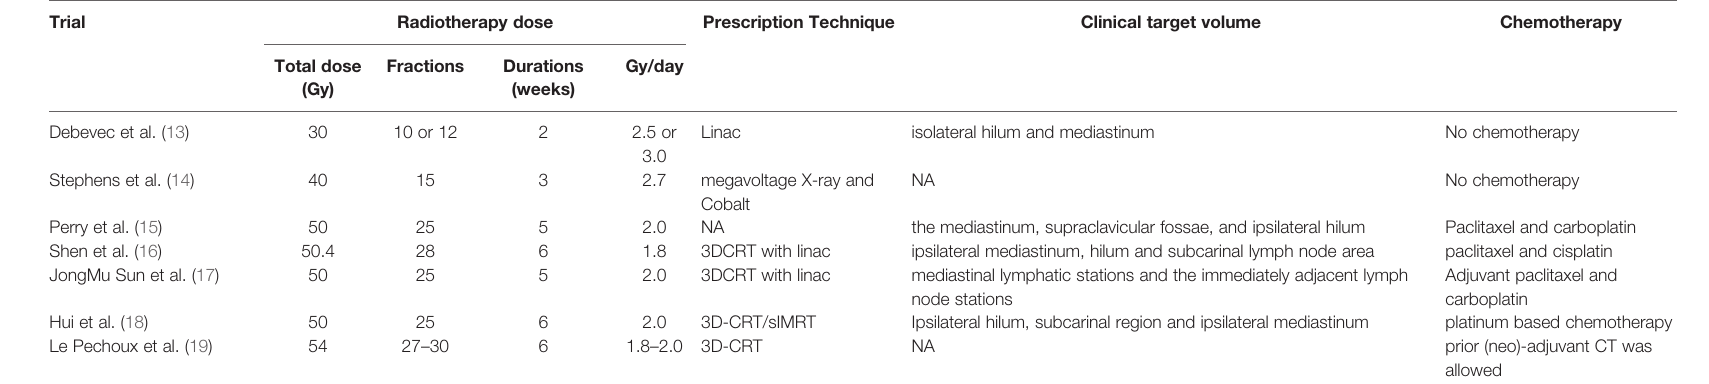
TABLE 2 | The detail of radiotherapy and chemotherapy of included